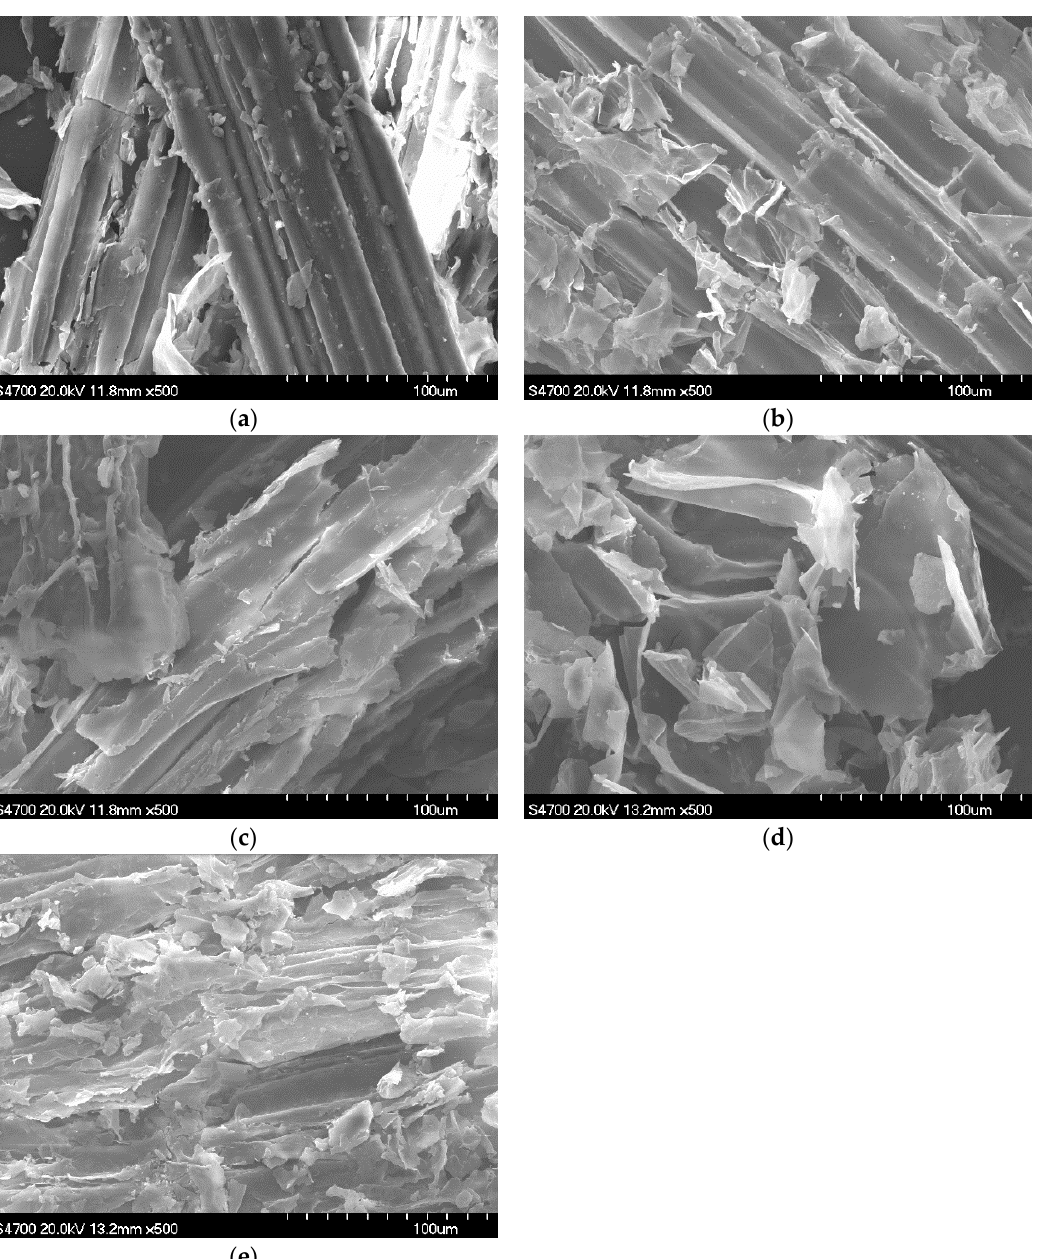
Figure 5. SEM images of corn stover. ( a ) Untreated; ( b ) T24 (Pretreated with 2% urea for 24 h); ( c ) T48 (Pretreated with 2% urea for 48 h); ( d ) T72 (Pretreated with 2% urea for 72 h); ( e ) T96 (Pretreated with 2% urea for 96